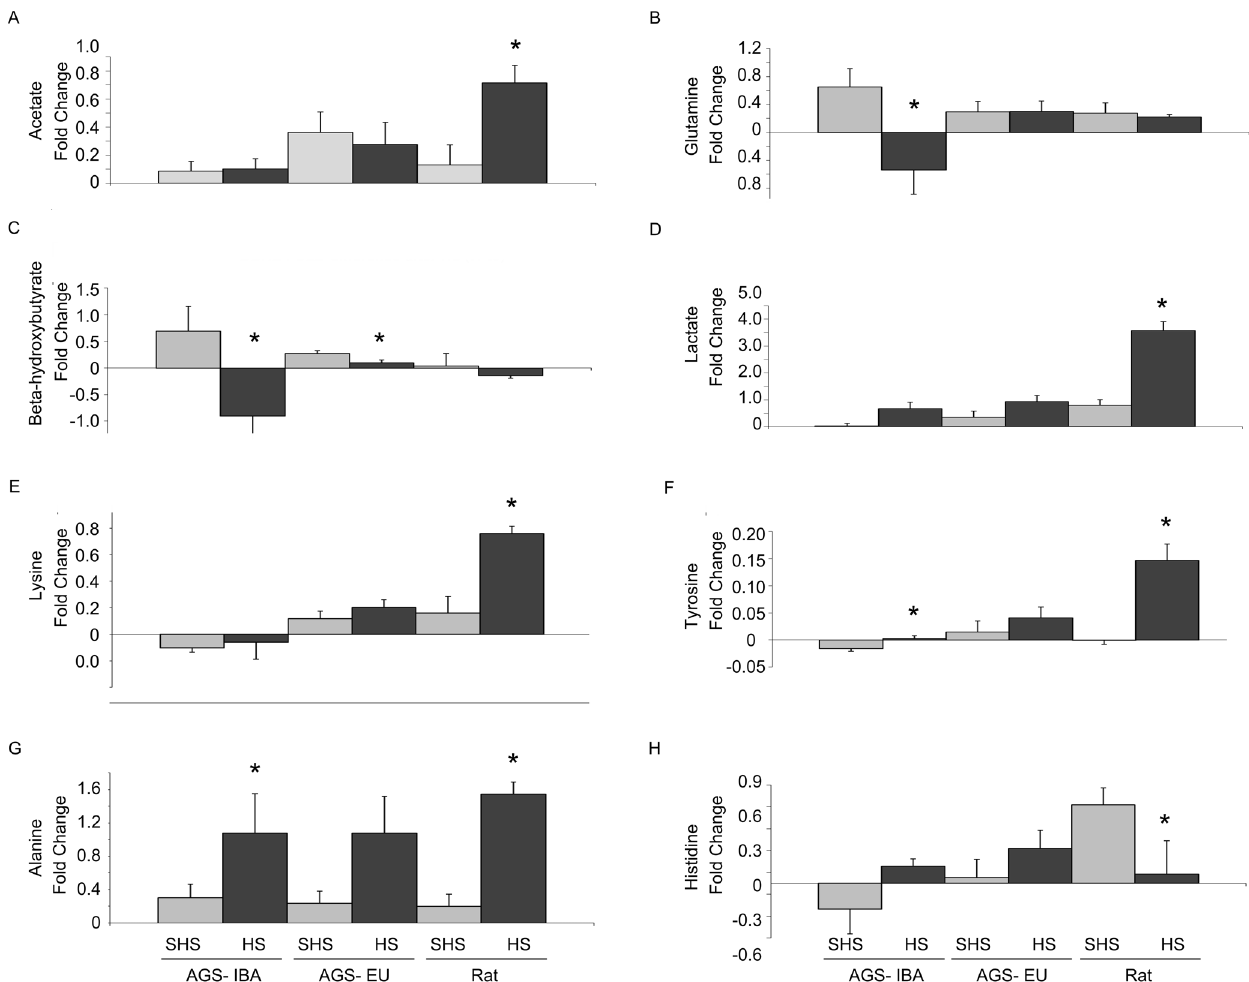
Figure 5. Fold change in plasma metabolites before and after hemorrhagic shock. Fold change in circulating metabolites before and after hemorrhagic shock (HS) or sham hemorrhagic shock (SHS) in winter interbout arousal (IBA) arctic ground squirrels, summer euthermic (EU) arctic ground squirrels, and rats. Data presented as mean 6 SEM. Asterisks indicate p , 0.05 vs. SHS of same group, Tukey test. n=6–8 for all groups. Concentrations of metabolites are shown in Table 2.